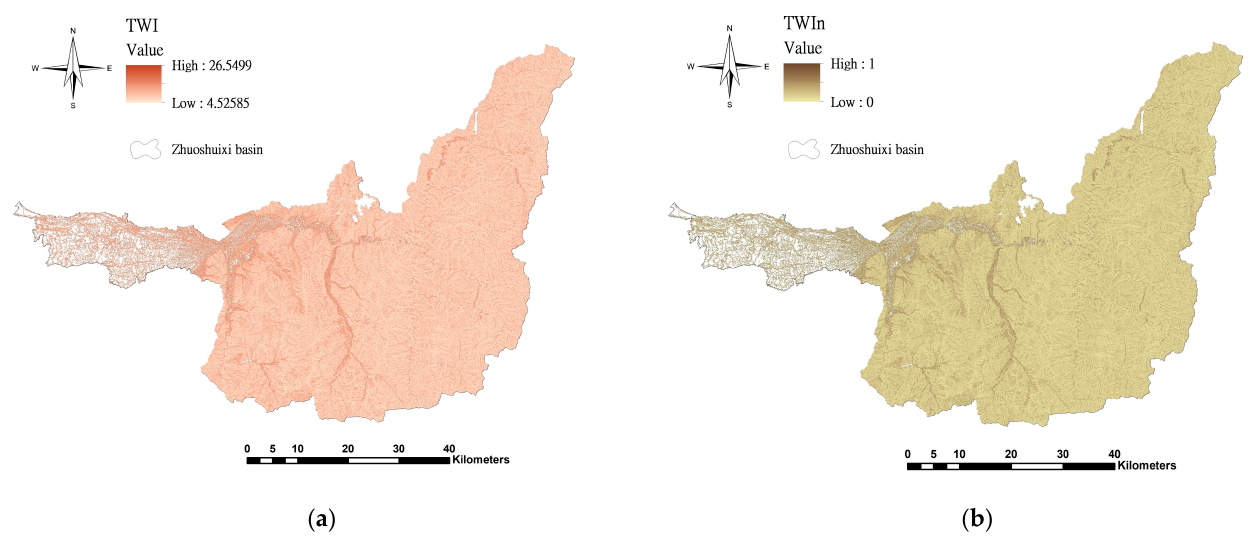
Figure 5. ( a ) The topographic wetness index and ( b ) the normalized topographic wetness index.